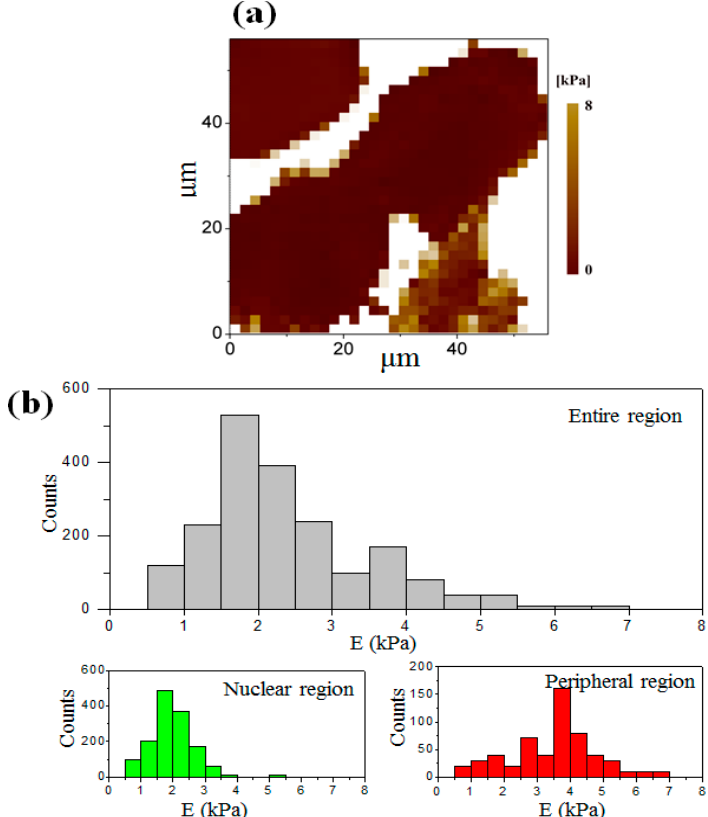
Figure 6. ( a ) The elastic modulus map of a single cell at the telophase of mitosis with a resolution of 32 × 32; ( b ) the histogram of the elastic modulus distribution of one daughter cell in the whole region (gray), the nuclear region (green), and the peripheral region (red).